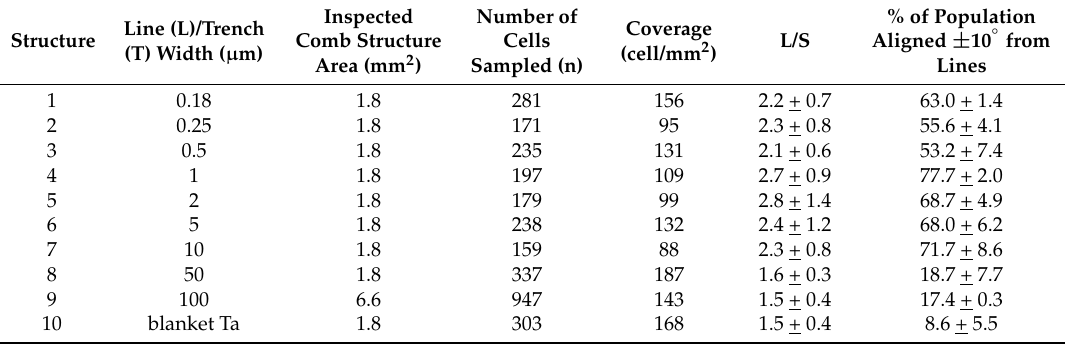
Table 2. Data summary of number of cells inspected (n), percent population of cells with 10 ◦ > φ > − 10 ◦ of the line axis, and axis length ratio (L/S). The culture media initial cell concentration used was ~0.5 × 10 5 cells/mL. Data spreads correspond to one standard